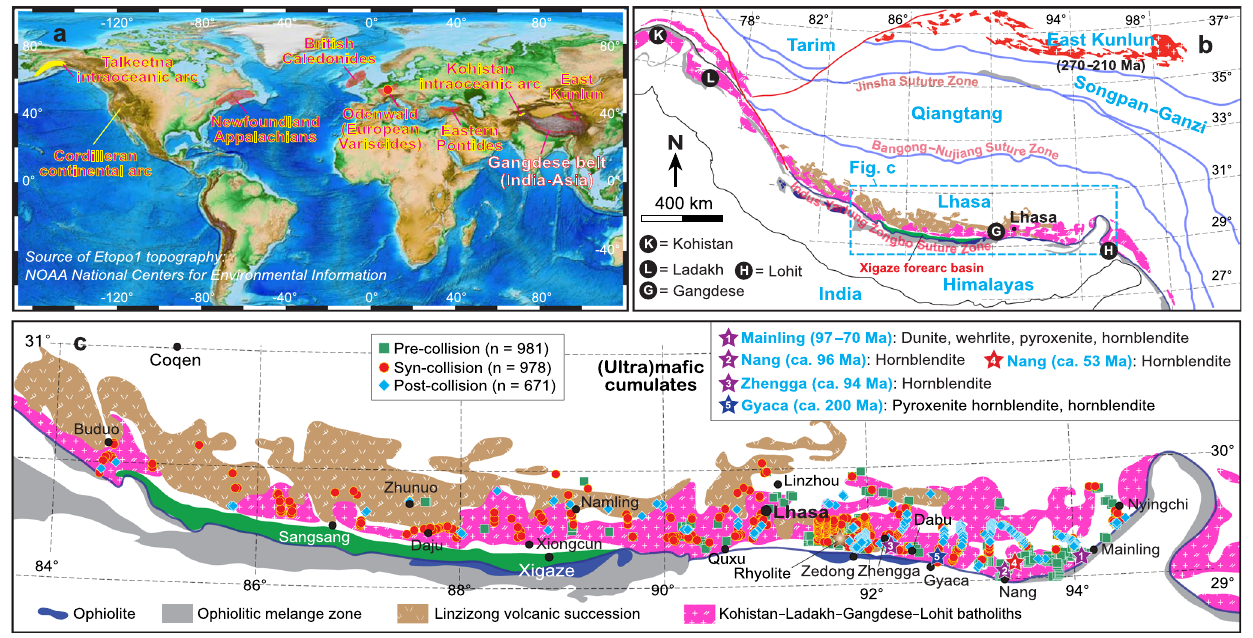
Fig.1|Present-daytopographyoftheEarthandthetectonicframeworkofthe Tibetan Plateau. a Etopo1 topography showing the locations of major collisional zonesandmagmaticarcs. b LocationoftheGangdesemagmaticbelt(includingthe Gangdese Batholith and Linzizong volcanic succession) in the context of the